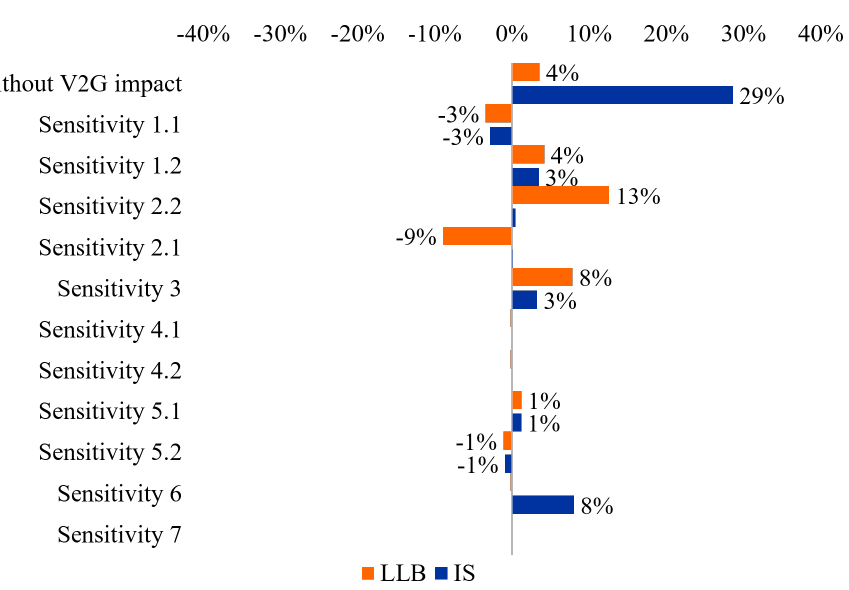
Figure 15. Relative change of V2G TCO for a Nissan Leaf in a public charging case (source: own